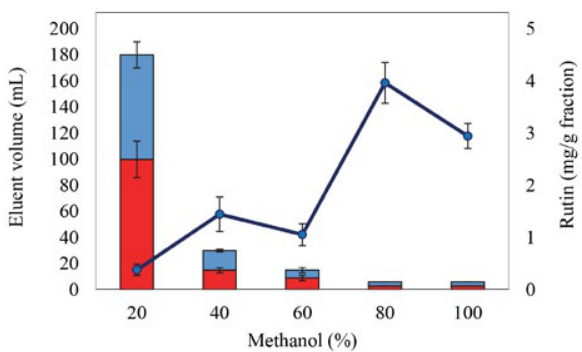
Figure 1. Total volume of eluent (line bar) and volume of eluent containing rutin (dot bar) at the primary axis, and rutin fractionat- ed (line graph) from the methanolic system of solid phase extrac- tion at the secondary axis